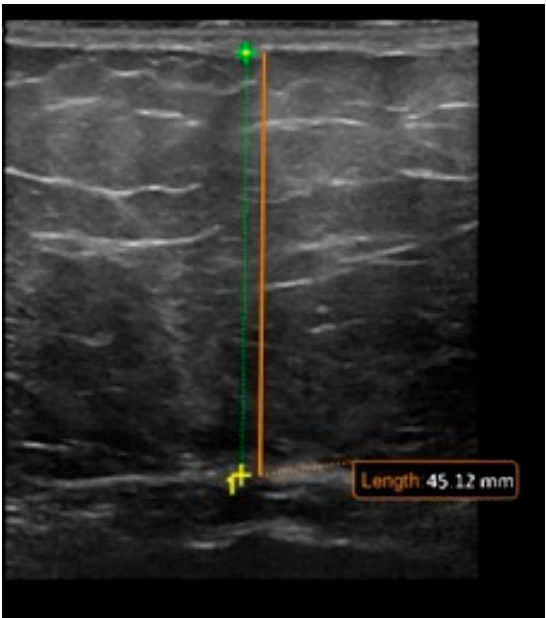
Figure 3. Ultrasound image showing subcutaneous abdominal wall adipose tissue thickness = 45.12 mm, approximately 2 cm below the umbilicus. Prepared by the authors. Courtesy of the Pediatric Clinical Hospital Sibiu, Lucian Blaga University of Sibiu.